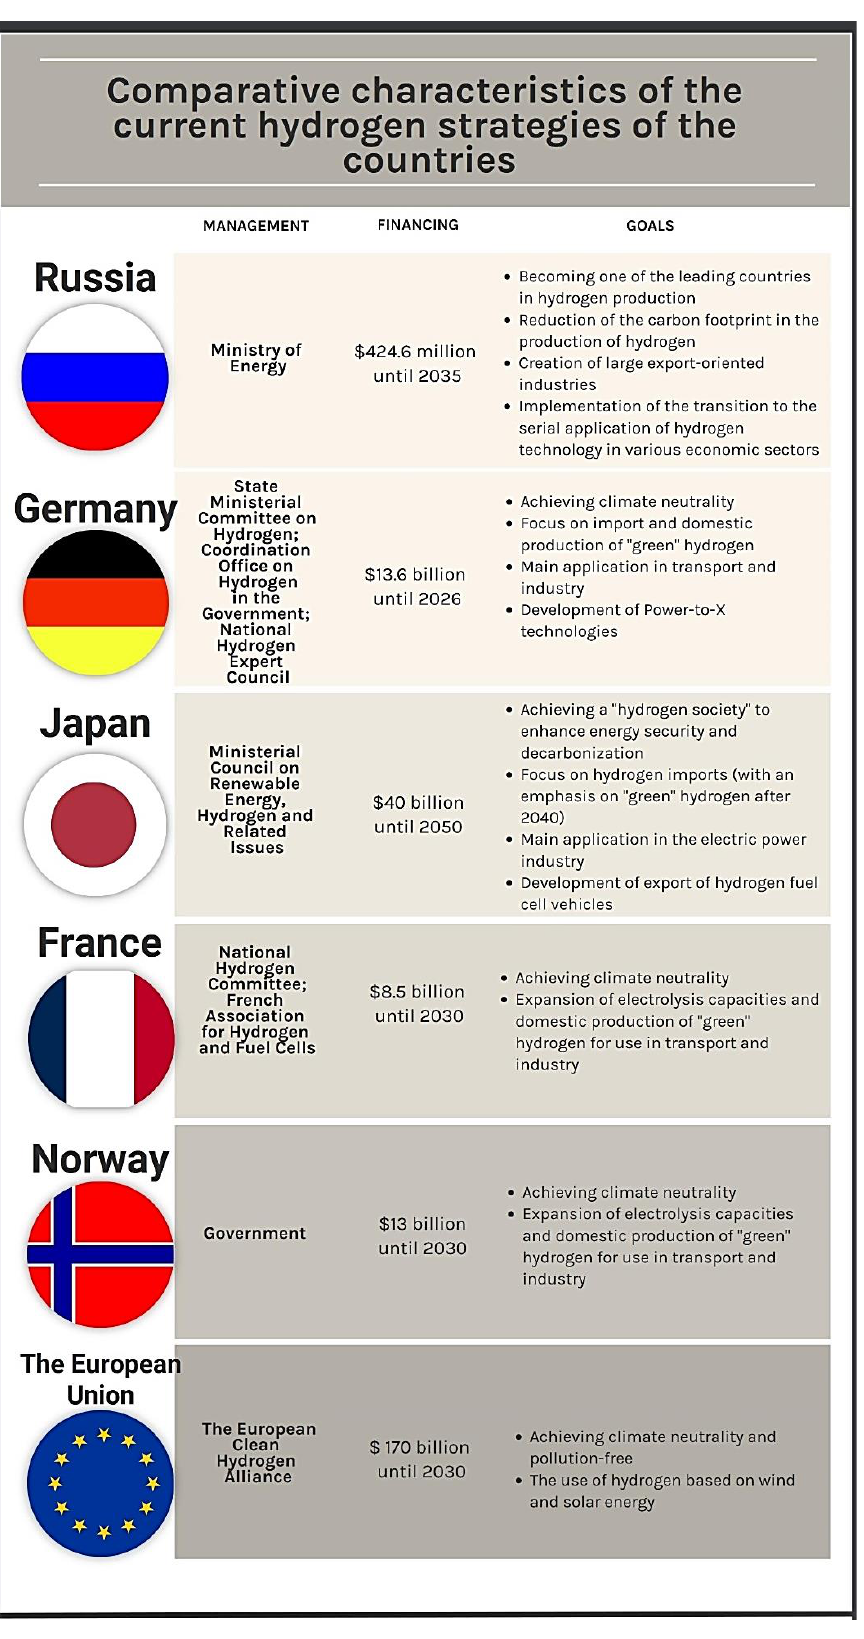
Figure 4. Comparative characteristics of the current hydrogen strategies of some countries, compiled by sources [35,44].